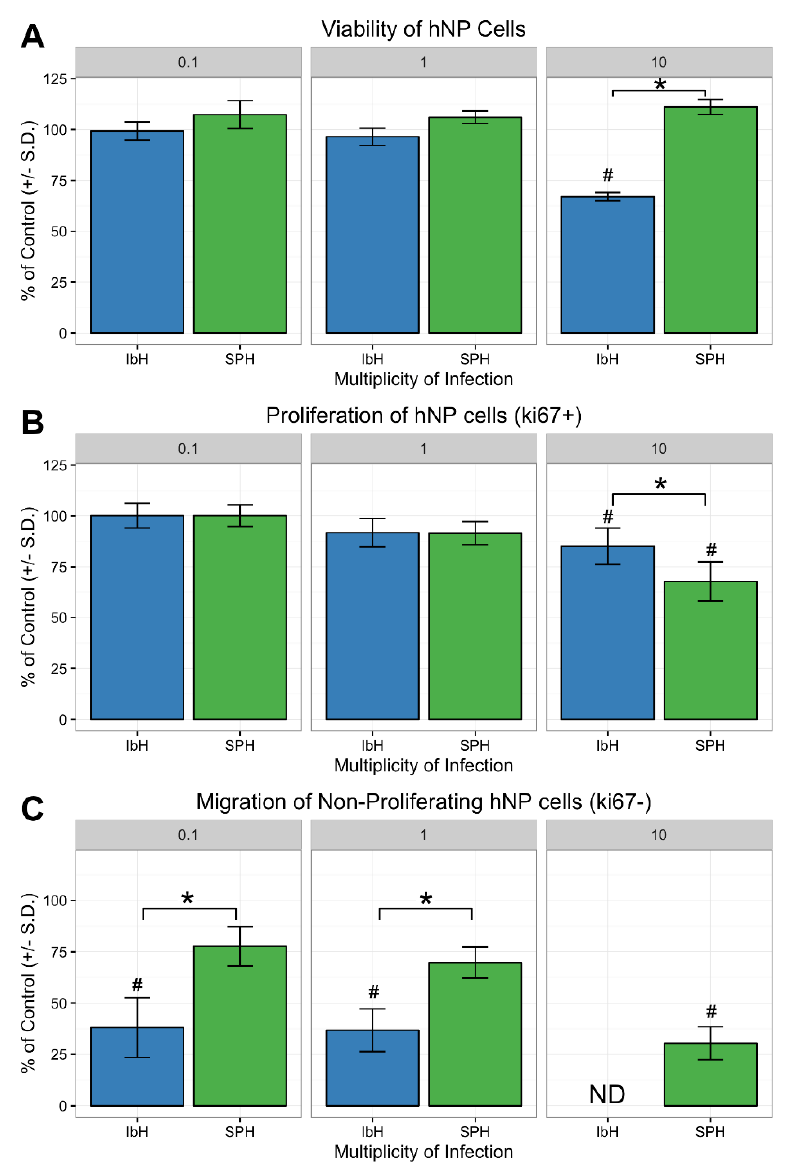
Figure 4. ZIKV infection decreased hNP cell proliferation and migration. ( A ) Only infection with MOI 10 of African-lineage ZIKV demonstrated a significant impact on cell viability after 48 h, whereas infection with SPH did not decrease viability. ( B ) The proliferation of hNP cells after ZIKV infection was significantly decreased following infection with SPH as determined by quantification of Ki67 expression. ( C ) The migration of hNP cells was disrupted by both IbH and SPH infections. IbH infection severely inhibited migration at MOI 10 to such an extent that no acceptable data were collected (shown as ND). * demonstrates p < 0.05 significance between IbH and SPH and # demonstrates p < 0.05 significance difference from non-infected control.